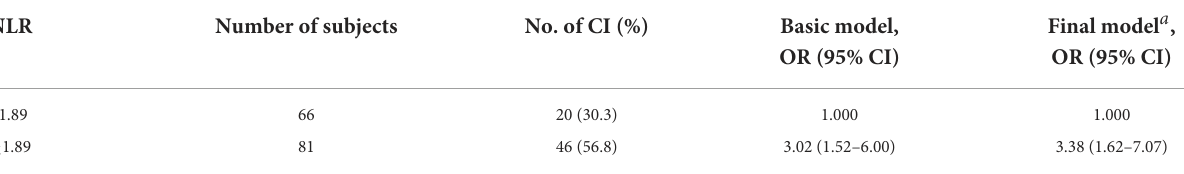
TABLE 4 Odds ratios of CI according to NLR cutoff before and after adjustment.